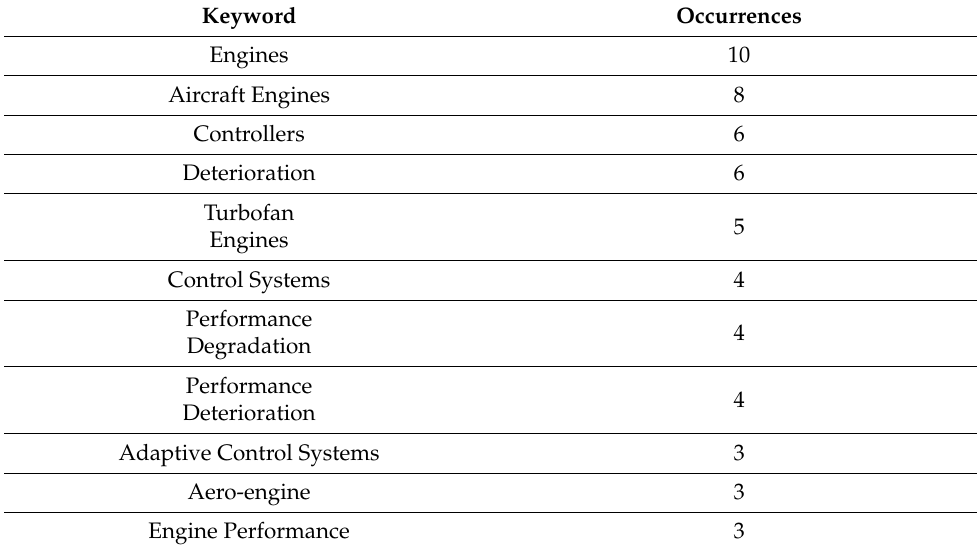
Table 2. Active keywords in the identified